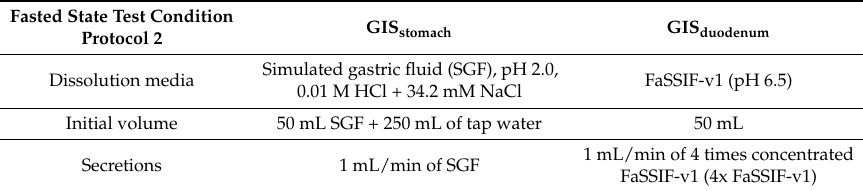
Table 3. Overview of dissolution media, initial volumes, and secretion rates applied in the GIS device for the second set of dissolution experiments with a higher level of biorelevance by adding NaCl to SGF and by adding sodium taurocholate and lecithin to the phosphate buffer in order to obtain fasted state simulated intestinal fluids (FaSSIF-v1). The jejunal compartment was empty at the start of the